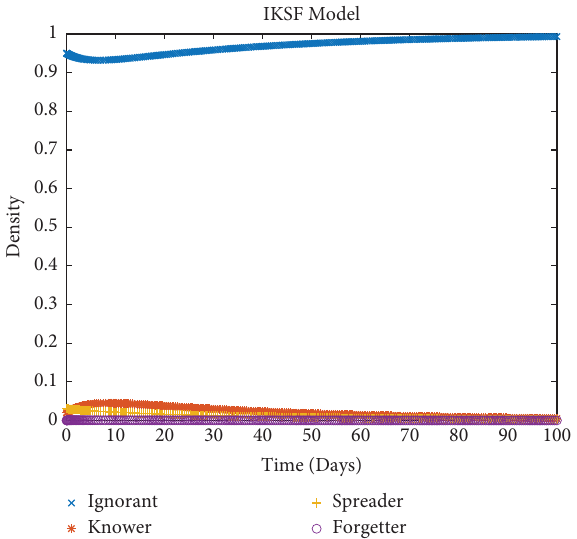
Figure 5: Diagram of density change of four types of population when R